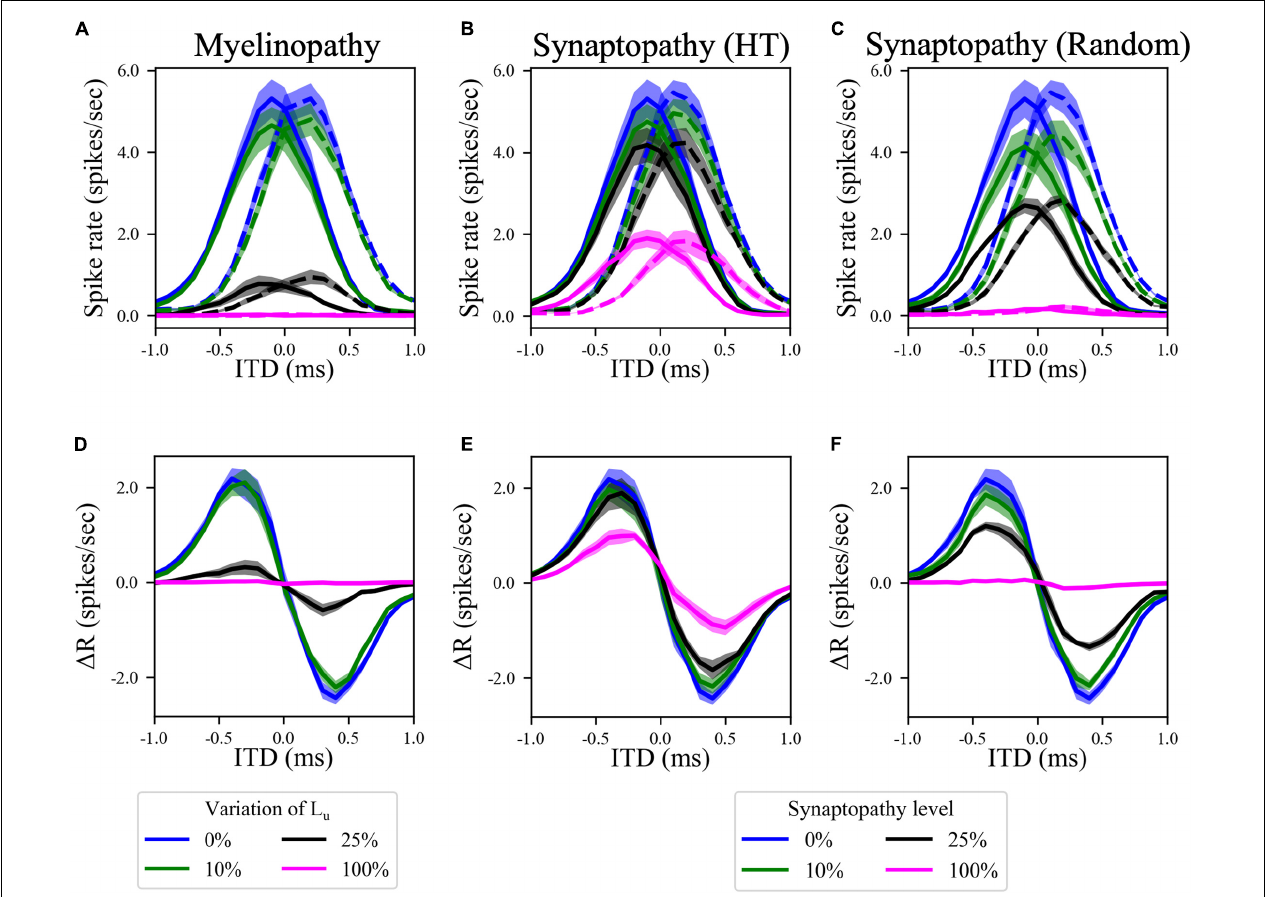
FIGURE 4 | Disruption in the peripheral auditory system decreased MSO spike rates for all ITDs, resulting in smaller differences between left and right MSO activity and hence lower ITD sensitivity. (A–C) Spike rates of left (solid lines) and right (dashed lines) MSO cells as a function of ITD for various levels of (A) myelinopathy at SGN cells, (B) synaptopathy at IHC-HT SGN synapses and (C) random synaptopathy in IHC-SGN synapse population. (D–F) The difference between left and right MSO firing rates (MSO left –MSO right ) at various levels of (D) myelinopathy, (E) synaptopathy at HT synapses and (F) random synaptopathy. In myelinopathy, 0% variation of L u represents a circuit with a homogeneous population of SGNs with 10 µ m long L u , and 100% variation of L u represents a circuit with a heterogeneous SGN population with 10 µ m ≤ L u ≤ 20 µ m. In both synaptopathy scenarios (HT and random), 0% synaptopathy indicates all IHC-SGN synapses are intact. In HT-Synaptopathy a level of 100% means that all IHC-HT SGN synapses are deficient, whereas the same number of synapses are randomly removed in random synaptopathy (1/3rd of all